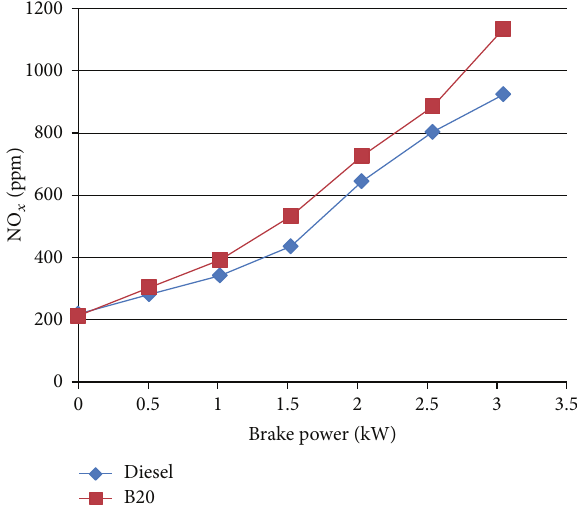
Figure 13: NO 𝑥 emission versus brake